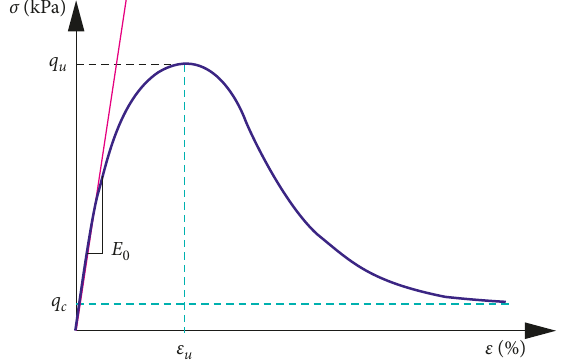
Figure 8: Typical stress-strain curve occurred during unconfined compression